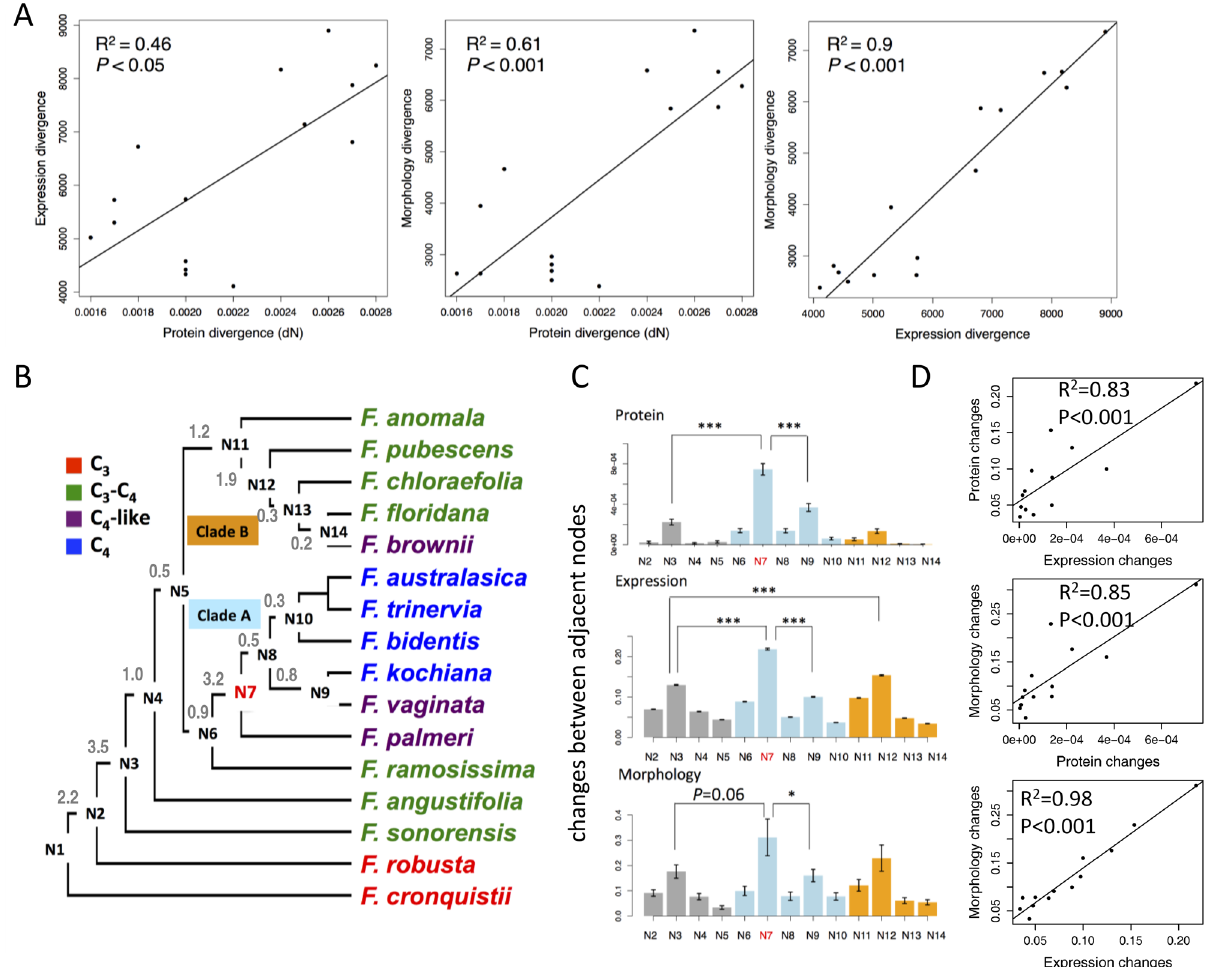
Figure 6. Coordinated evolution of protein sequence, gene expression and morphological traits with apparent major changes. Significant linear correlation between protein divergence, gene expression divergence and morphology divergence were showed in ( A ). Protein divergence was calculated as non-synonymous mutation (dN). Expression divergence and morphology divergence were calculated as Euclidean distance based on quantile normalized FPKM values calculated here and coded morphology values from Mckown et al . 16 , respectively. All the relative divergences were the divergence between F. cronquistii and other Flaveria species. ( B ) The schema of Flaveria phylogenetic tree modified from Lyu, et al. 28 , branch length between ancestral nodes were labeled in grey. ( C ) The relative changes of each ancestral node compared with its earlier ancestral node in protein sequence, gene expression and morphological traits. P values are from One-way ANOVA analysis followed by Tukey’s Post Hoc test and adjusted by Benjamin-Hochberg correction. The significant levels are: *: P < 0.05; **: P < 0.01; ***: P < 0.001. The bar colors in grey/blue/orange represent species from basal/clade A/clade B of phylogenetic tree, respectively. ( D ) Pearson correlations between changes of ancestral nodes in protein sequence, gene expression and morphological